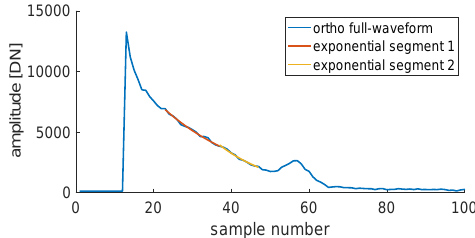
Figure 9. Segmentwise exponential function approximation for a real ortho full-waveform.